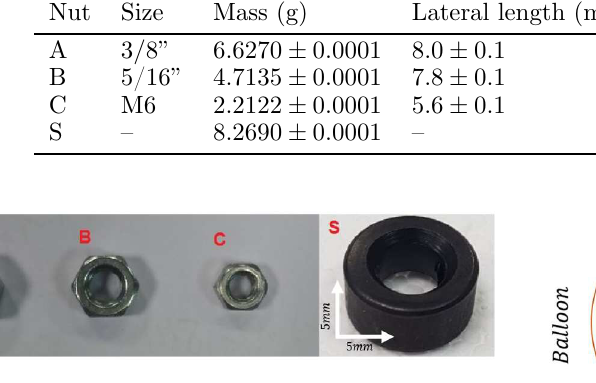
Fig. 1. Nuts used in our experiments.